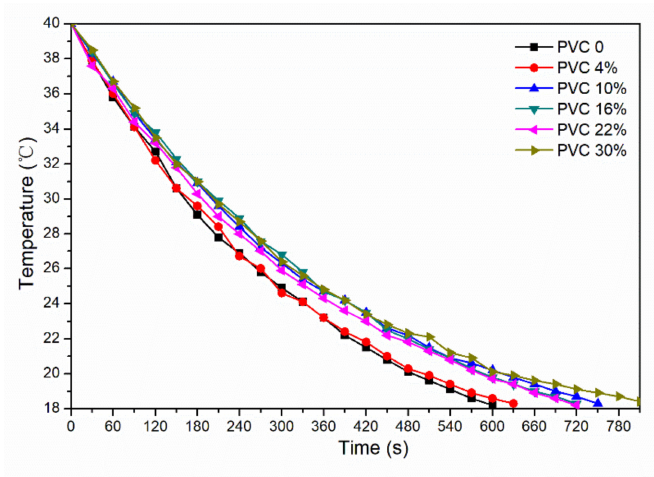
Figure 2. Influence of the PVC of glass fiber powder on temperature change of the thermochromic waterborne coating under natural cooling.